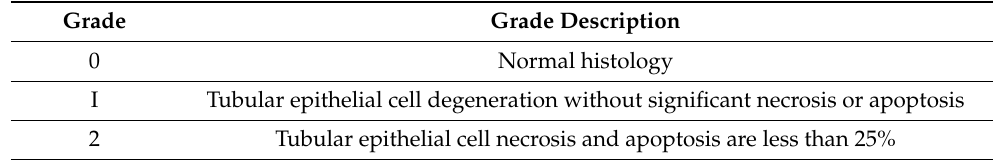
Table 2. Grading of the renal